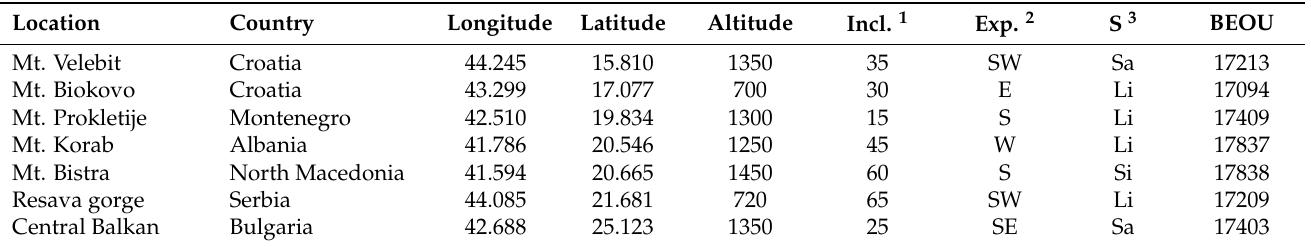
Table 1. Geographic distribution of studied Juniperus sabina L. var. balkanensis R.P.Adams & Tachev populations from the Balkans.